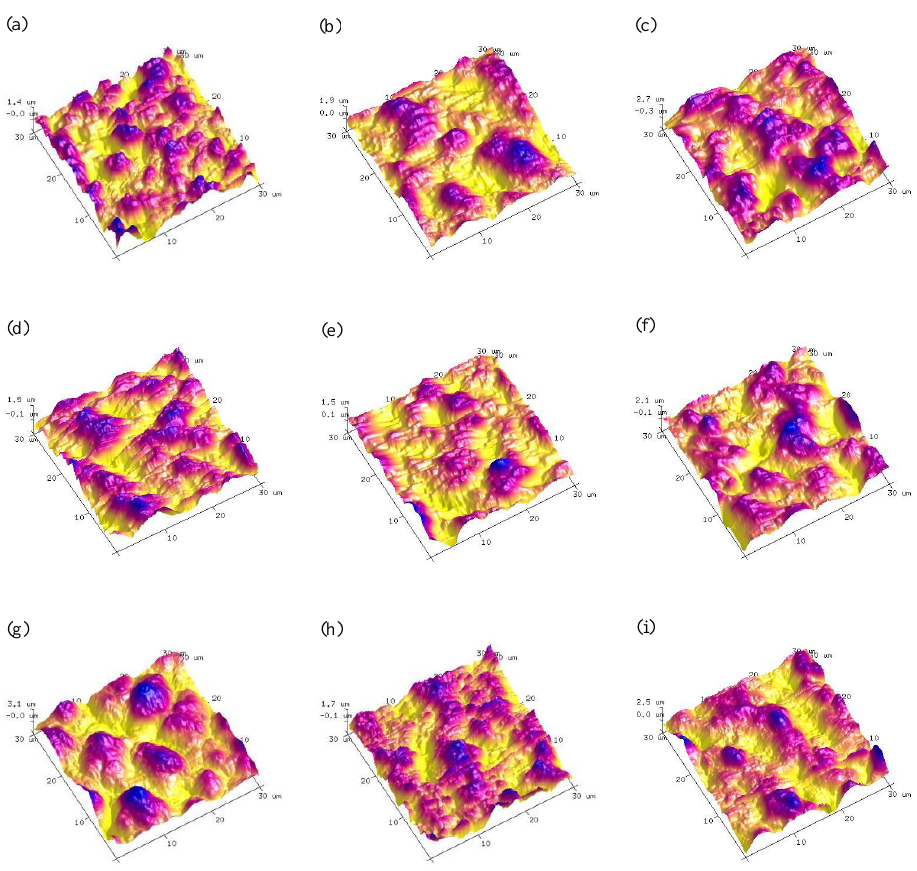
Figure 1. AFM image of MAO coatings obtained based on orthogonal experiment: ( a – i ) are 1 # – 9 # respectively. Table 2. Orthogonal experimental array and experimental results.